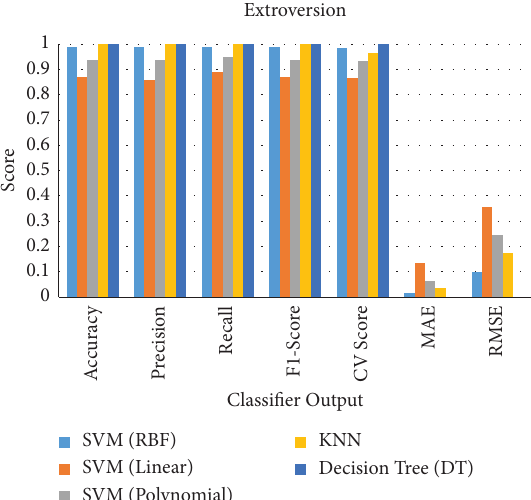
Figure 5: Overall score of the classifcation report, k -fold CV ( k � 10), MAE, and RMSE for the neuroticism model.